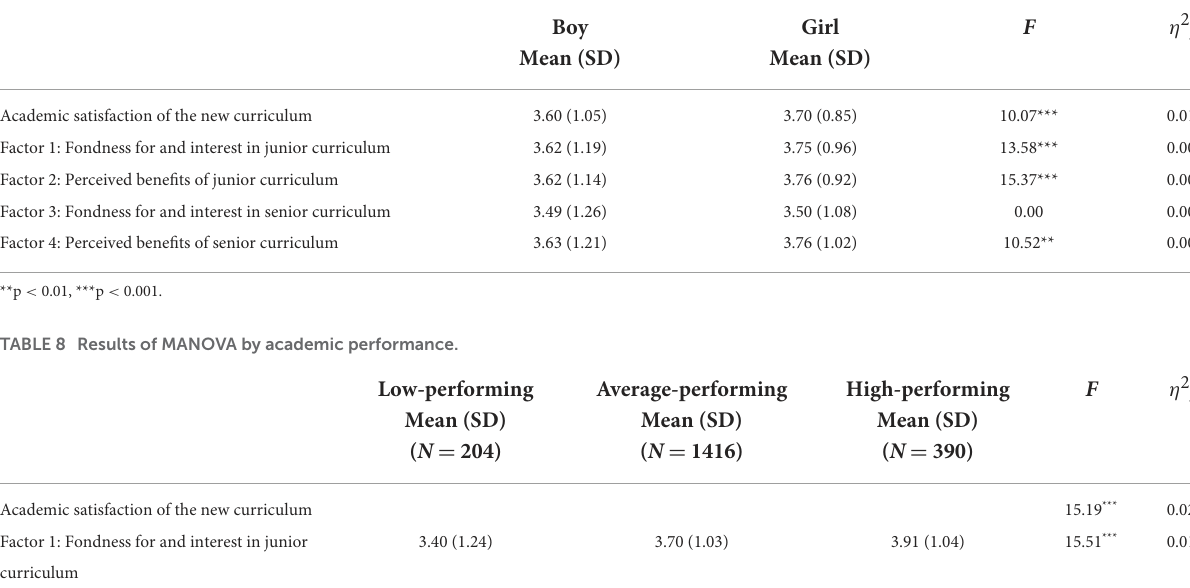
TABLE 7 Results of MANOVA by gender.